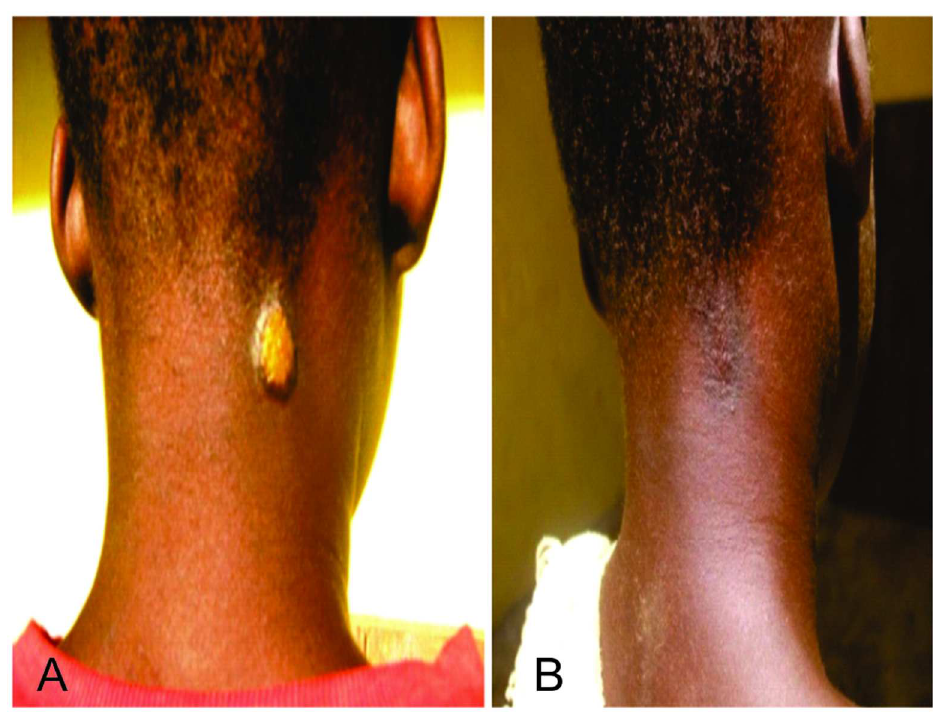
Fig 4. Before and After Treatment with Benzathine penicillin Papillomatous ulcer on the neck of patient showing complete healing after 3 weeks of treatment with benzathine penicillin: A. Before Treatment, B. After Treatment.